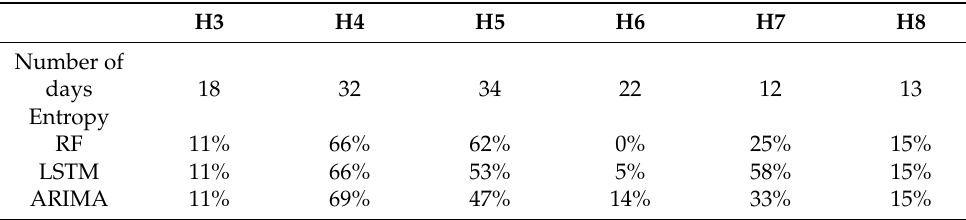
Table 9. Anomalous days of